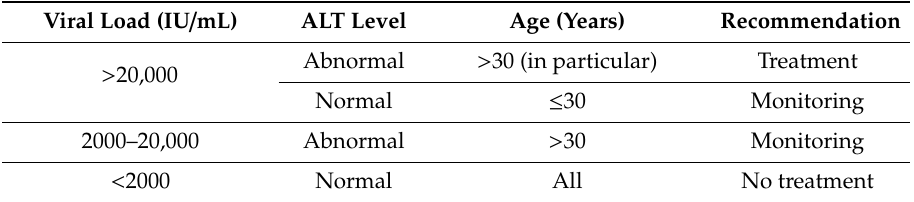
Table 1. WHO treatment indications for chronic HBV-infected patients.